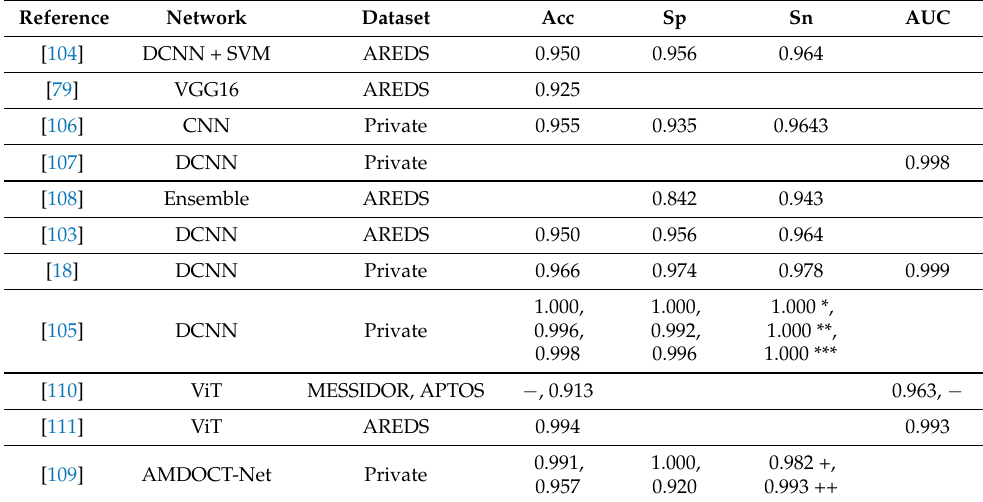
Table 4. Summary of AMD Detection